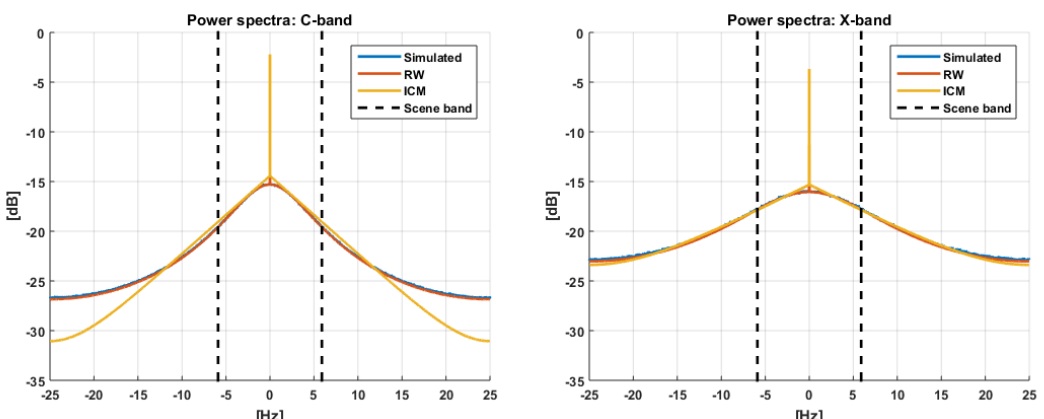
Figure 16. Power spectra of a set of decorrelating targets at C ( left ) and X ( right ) band. The blue line represents the average power spectrum of the targets. The red line represents the generalized Random Walk model spectrum. The yellow line represents the Billingsley ICM model. The black dashed lines represent the acquired scene bandwidth.